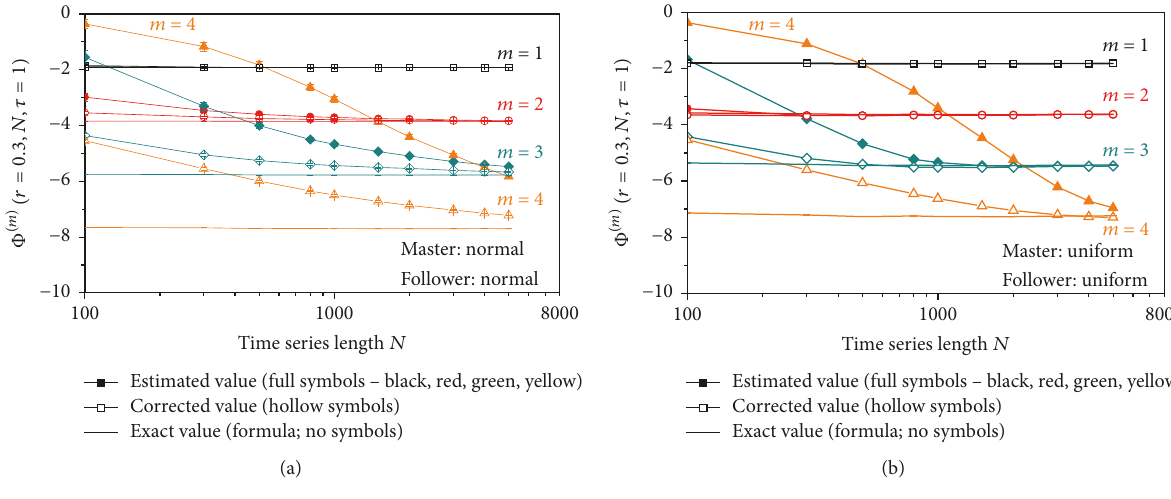
Figure 6: Summand Φ for 𝑟 = 0.3 : estimated omitting the zero probability, estimated and corrected, and calculated exactly using a